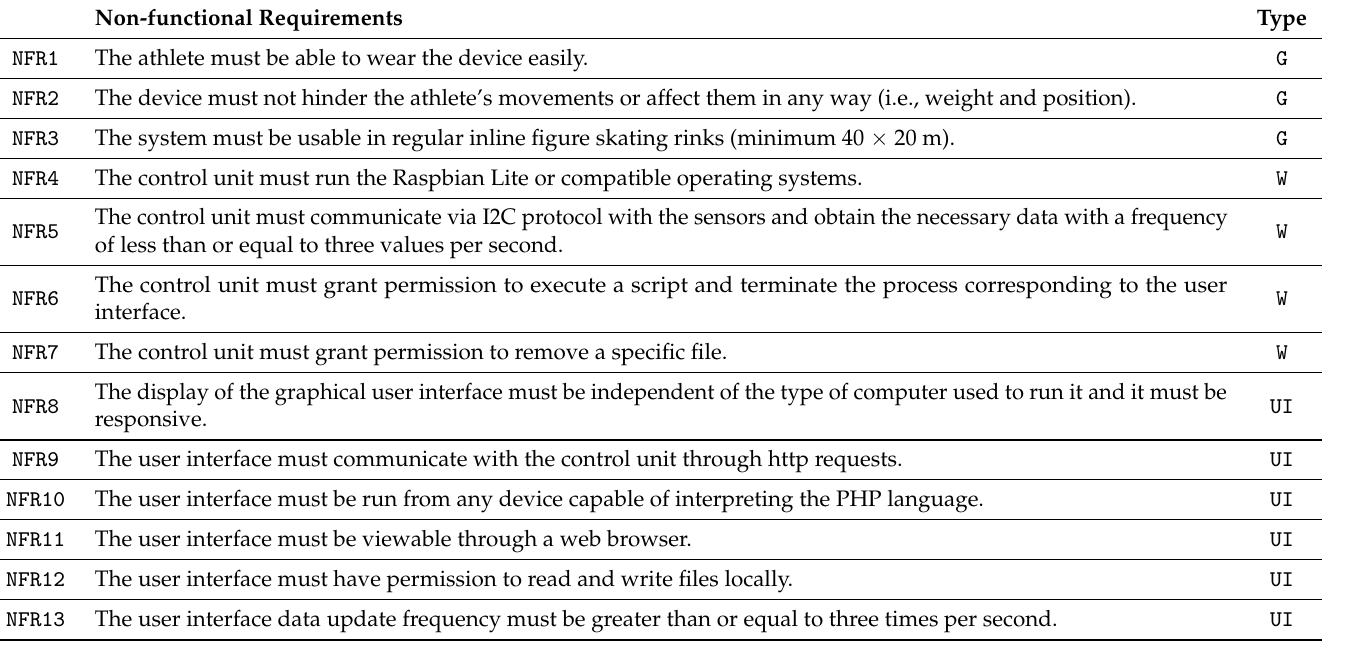
Table 2. The non-functional